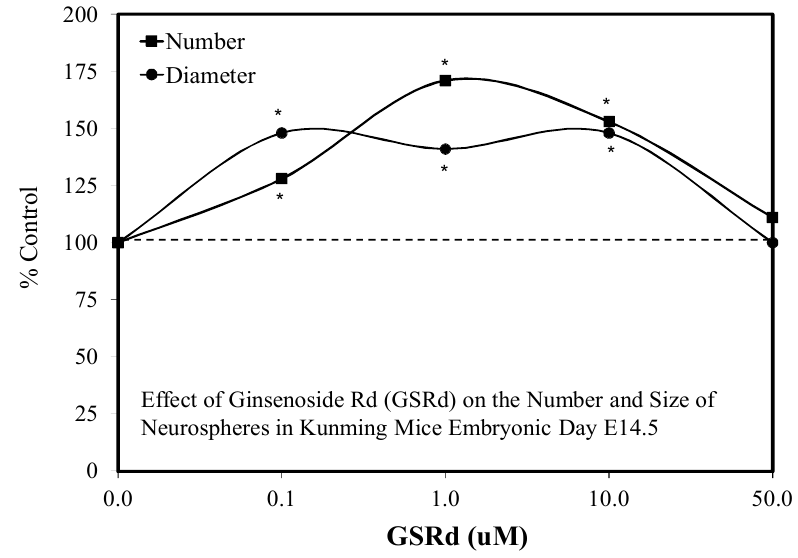
Figure 26. Effect of ginsenoside Rd (GSRd) on the number and size of neurospheres in kunming mice embryonic day E14.5 (Source: [104]). Each * represent statistical significance for a data point.